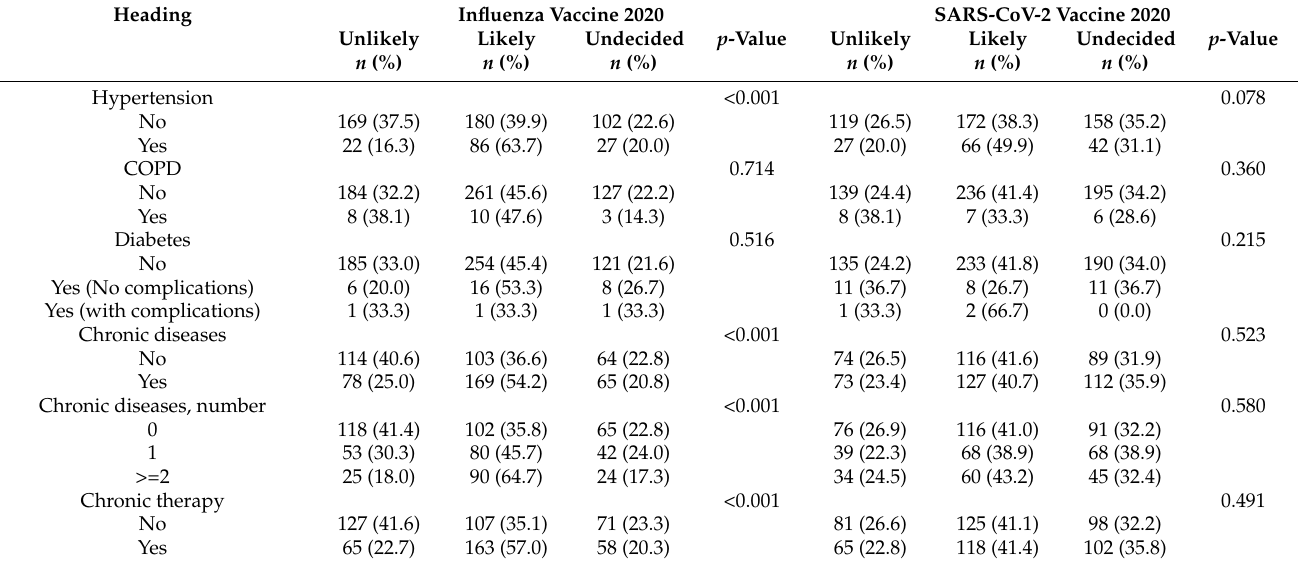
Table 2. Clinical characteristics of